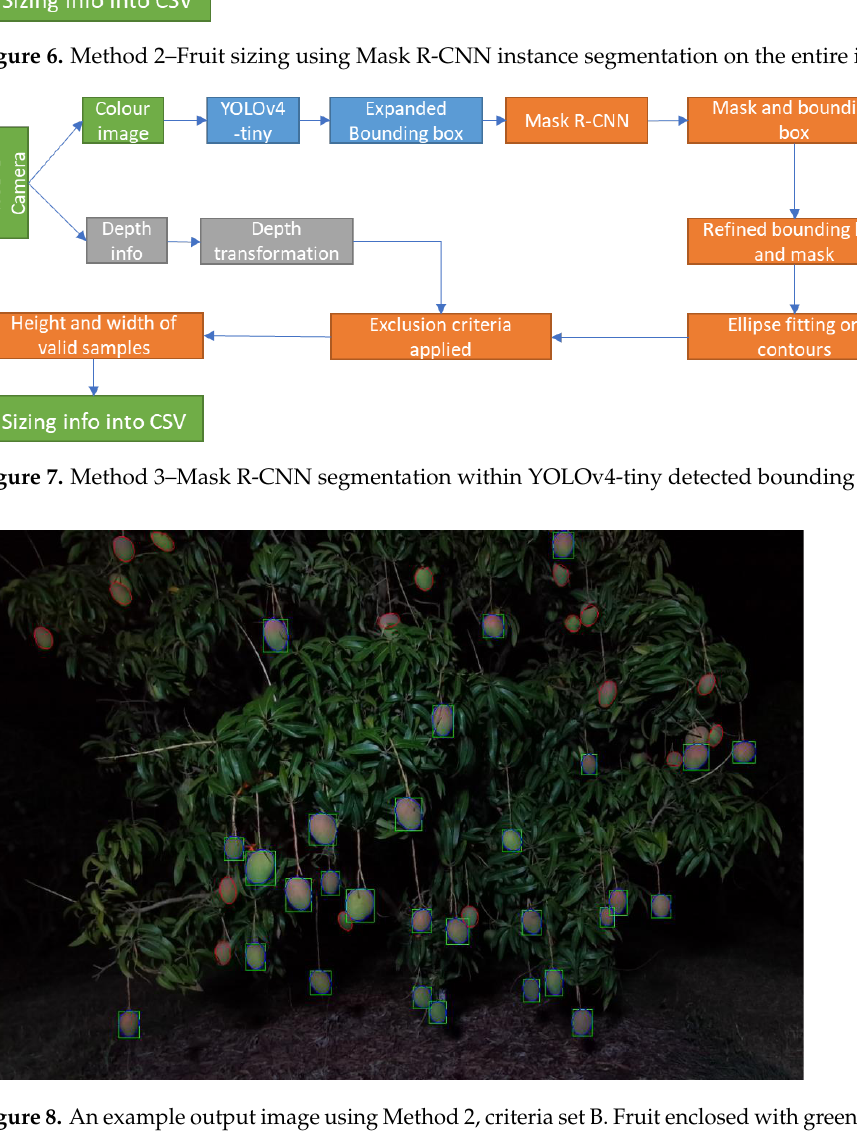
Figure 8. An example output image using Method 2, criteria set B. Fruit enclosed with green bounding box and blue ellipse are non-occluded fruits and considered for sizing. Fruit enclosed by red ellipse are occluded or failed to fulfil criterion set.